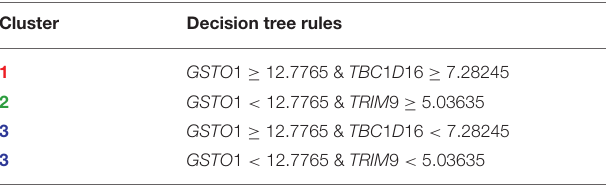
TABLE 4 | Tabular description of the decision tree classification model. Cluster